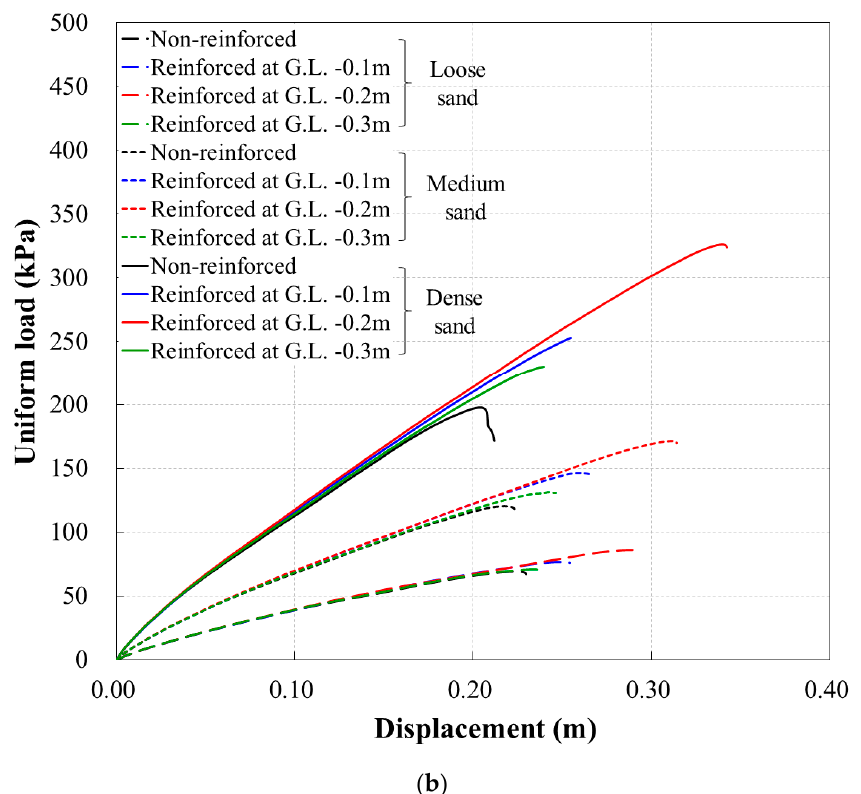
Figure 10. Relationship between the failure load and the displacement of the concrete mat according to the soil density and reinforced depth: ( a ) case of a point load; ( b ) case of a uniform load.